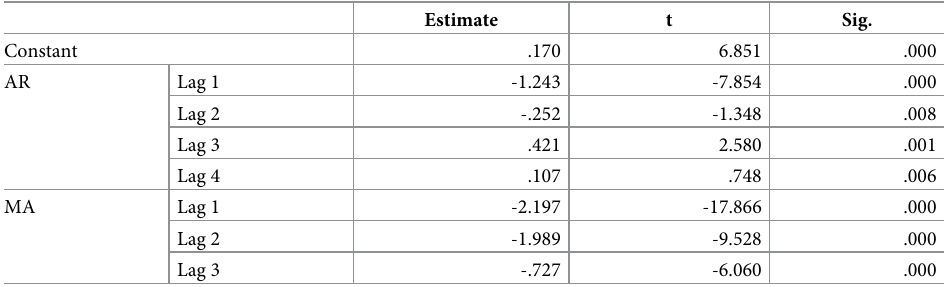
Table 6. STARMA (4,3) model. Estimate t Sig. Constant .170